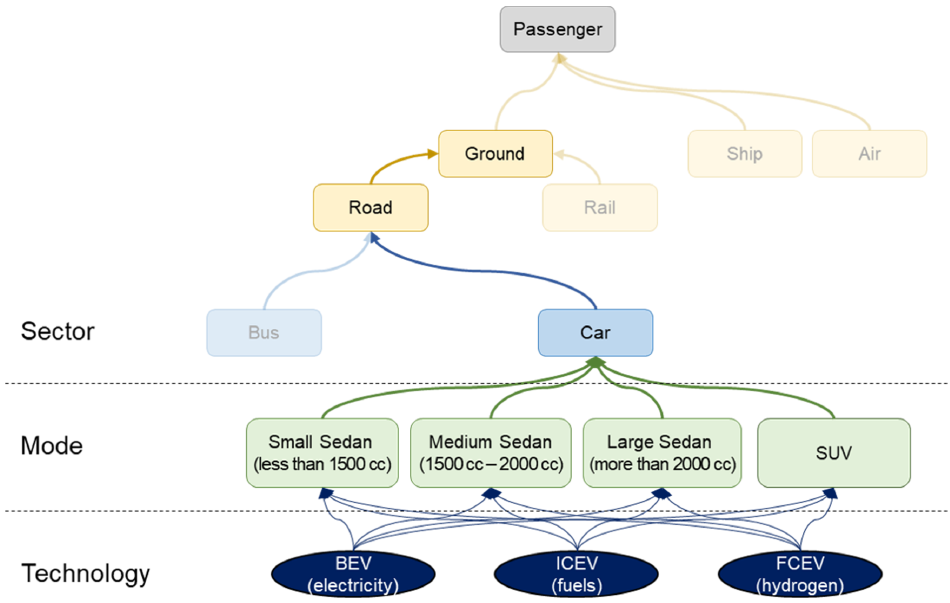
Figure 5. Representation of the transportation sector’s structure used in this study.